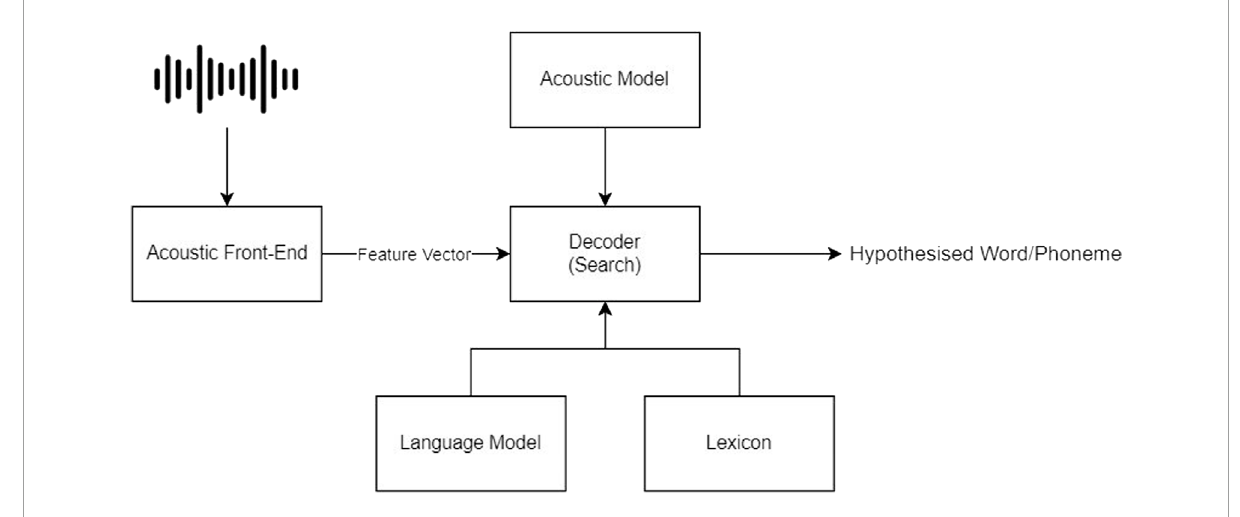
FIGURE 1 Automatic speech recognition abstract